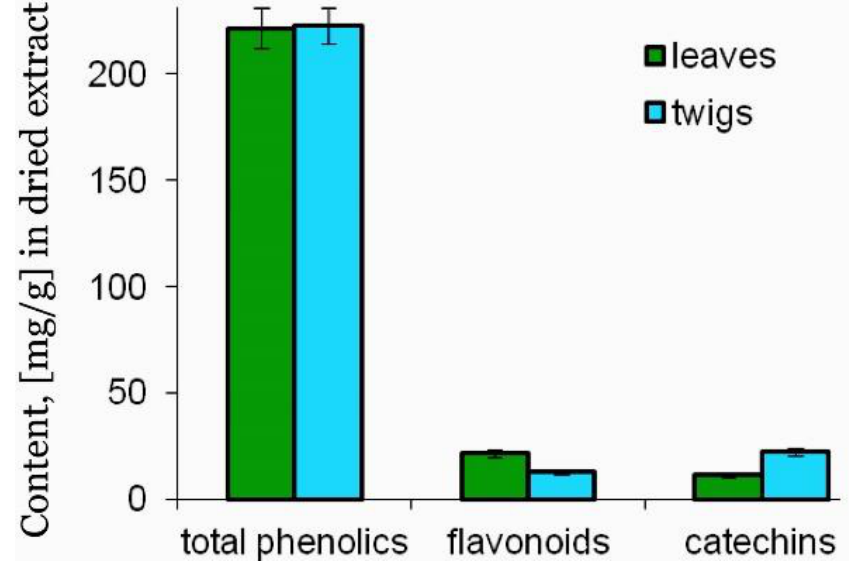
Figure 1. Total phenolic compound content in the leaf and twig extracts of R. canina . Values Figure 1. Totalphenoliccompoundcontentintheleafandtwigextractsof R.canina . Values(chlorogenicacid, (chlorogenic acid, quercetin, (+)-catechin, respectively, mg equivalents per gram of dry extract) are quercetin, ( + )-catechin, respectively, mg equivalents per gram of dry extract) are means ± SD ( n = means ± SD ( n = 3).